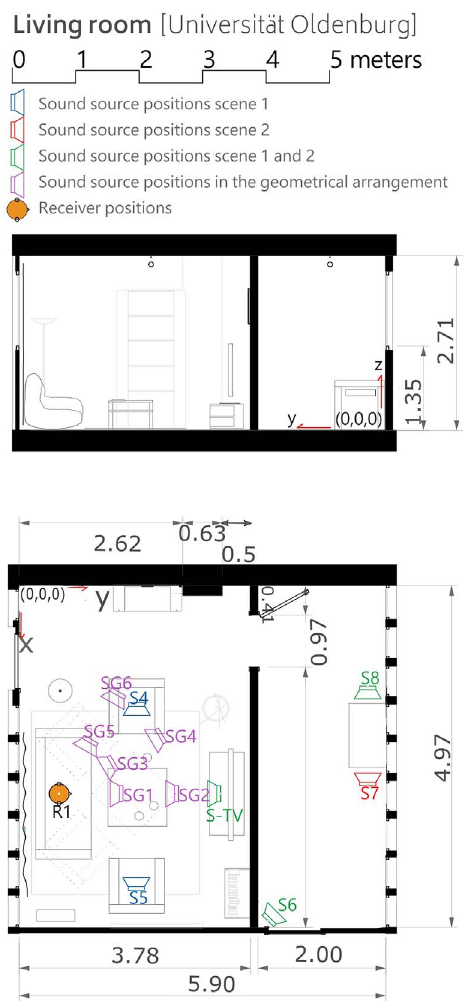
Figure 4. Cross section (top) and fl oorplan (bottom) of the living room environment in the same style as in Figure 2. Positions and orientations of receiver (letter R) and sources (letters S) are indicated by head, and loudspeaker symbols including their orientation in the horizontal plane. Source positions indicated in blue are attributed to scene 1, red to scene 2, green to both scenes. S-TV refers to the position of the television